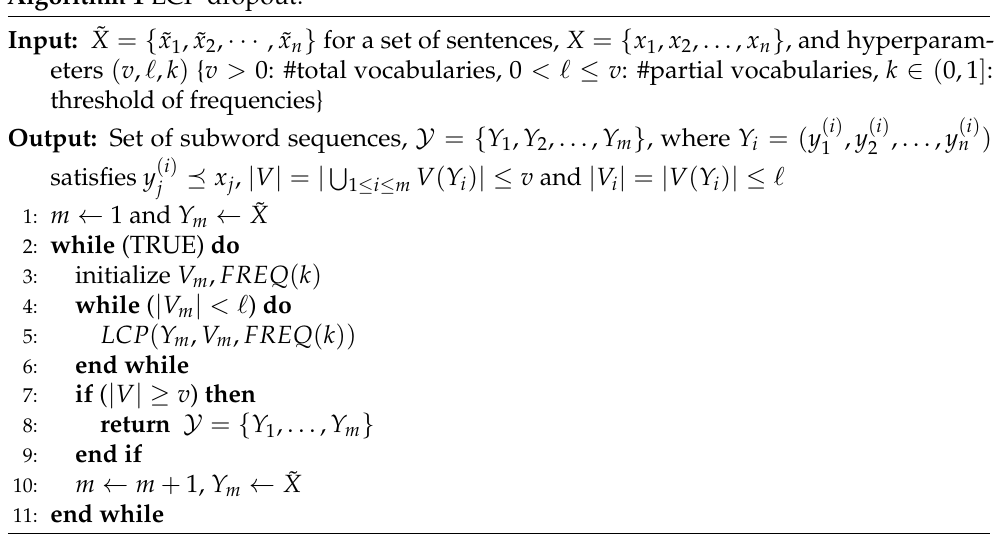
Algorithm 1 LCP-dropout.